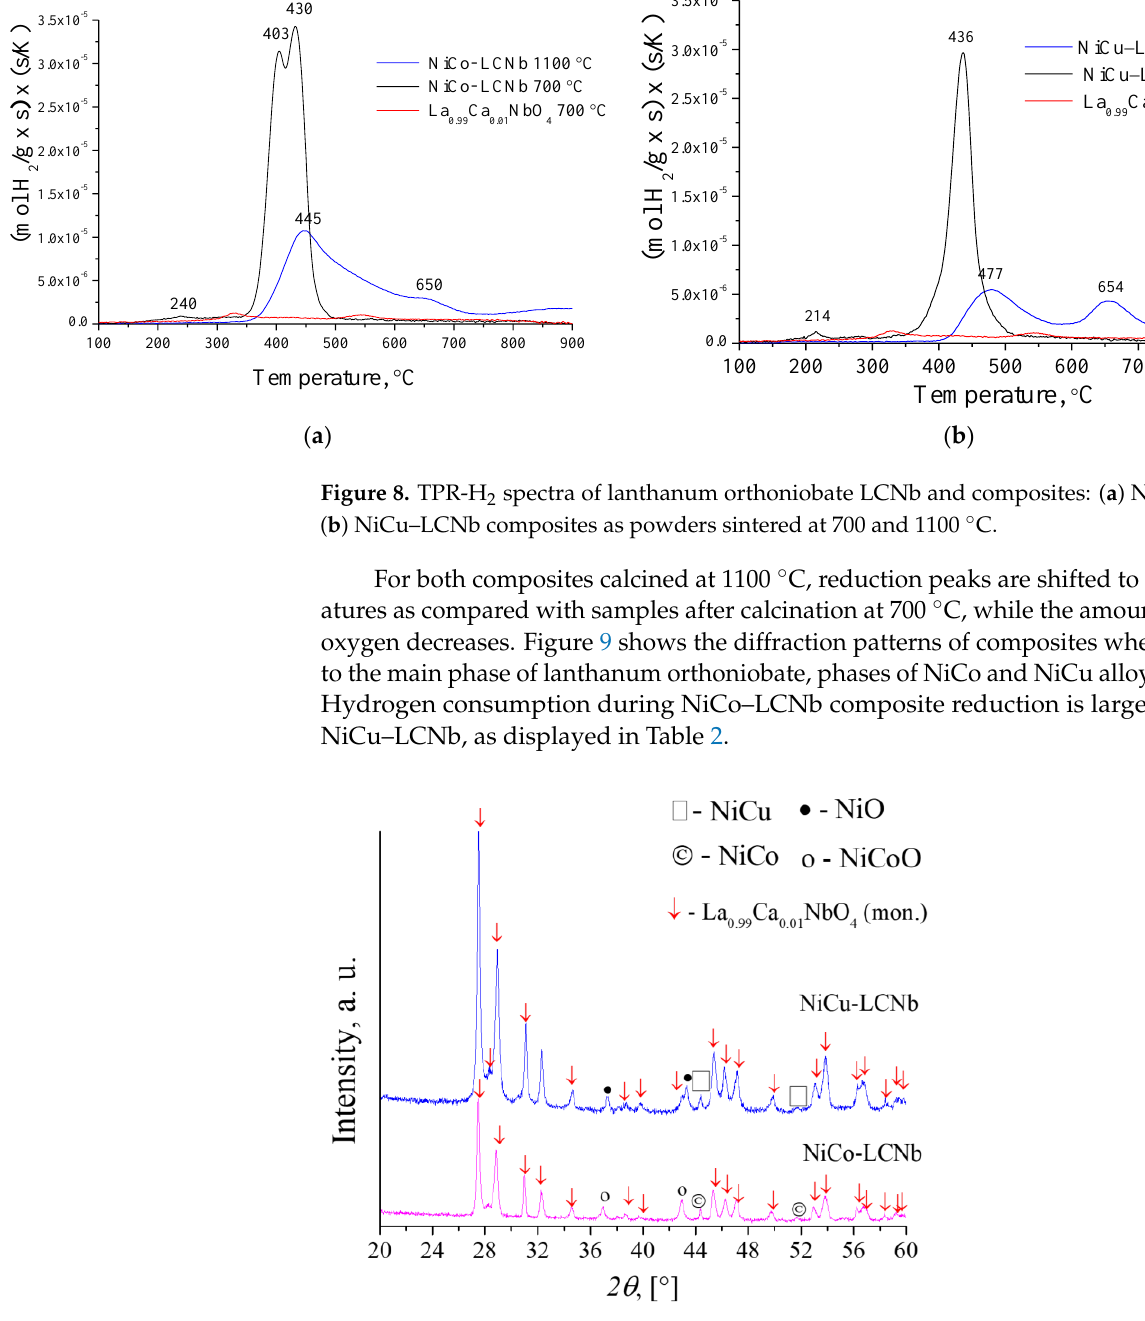
Figure 9. XRD patterns of the composites after reducing treatment at 600 °C for 2 h in H 2 /Ar. Table 2. Characteristics of H 2 -TPR